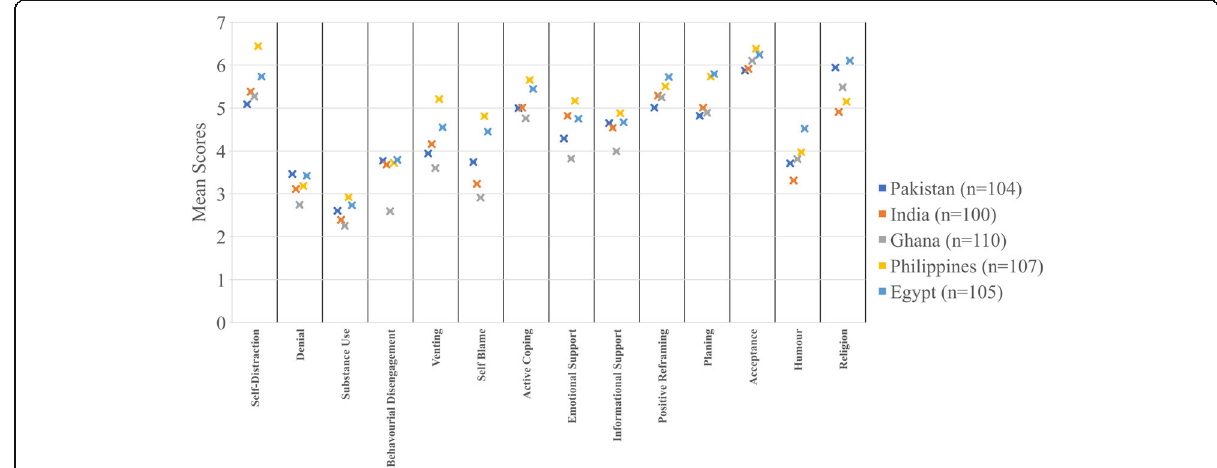
Fig. 2 Mean coping strategies score among countries